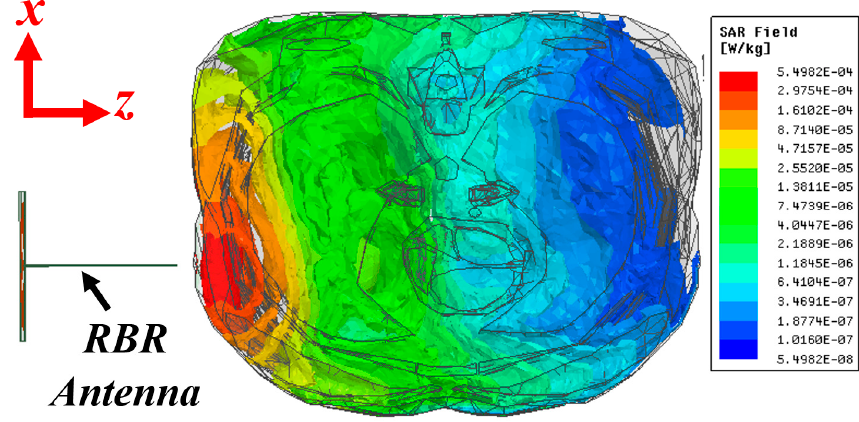
Figure 3. Calculated electric field density at sample frequency of 0.9 GHz. 3.2. Safety Criteria One of the critical requirements of an electromagnetic imaging scanner system is the safety of the utilized system, measured using the specific absorption rate (SAR). SAR defines the amount of absorbed electromagnetic energy by tissues exposed to an electromagnetic wave/field. To measure the amount of SAR inside the torso, a similar simulation setup for calculation of electric field is utilized, and the SAR values are calculated and presented in Figure 4. During this test, a power level